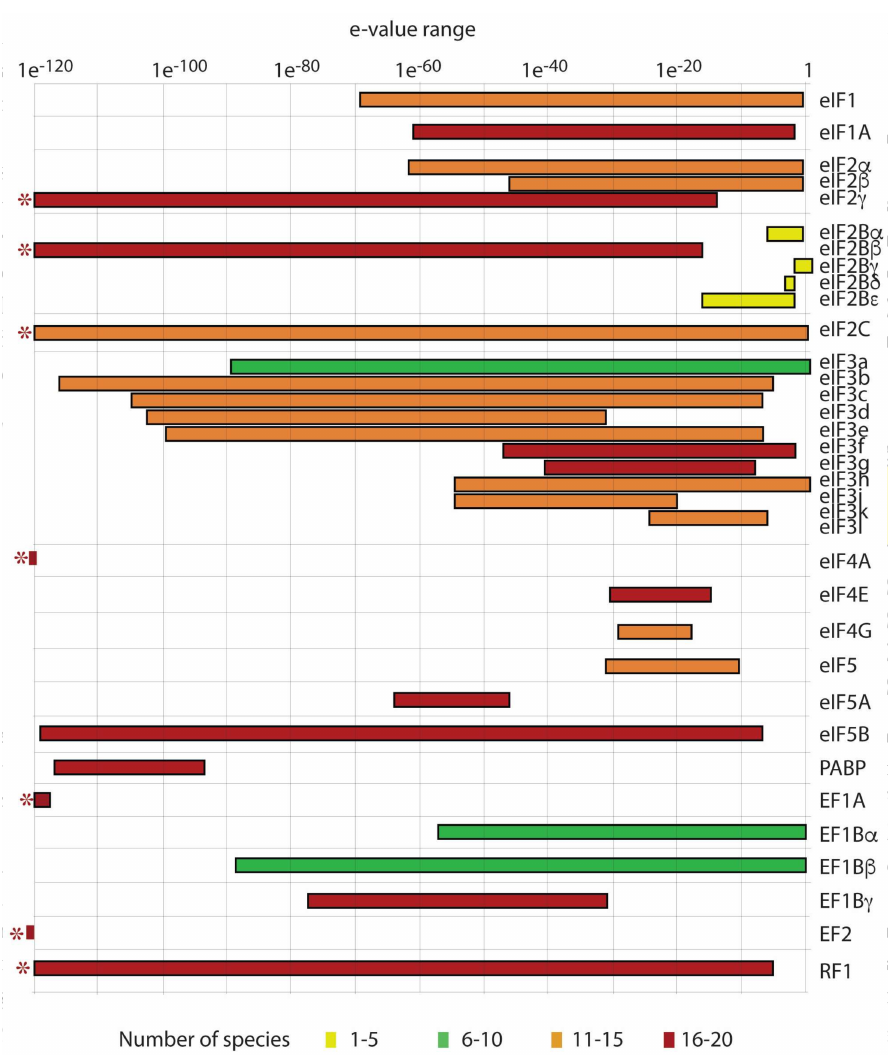
Figure 2. A list of eukaryotic initiation factors from Arabidopsis thaliana was used to query the dinoflagellate TSA using tBLASTn. Query sequences are listed at right, and the range of e-values (from e − 120 to 1) are shown as horizontal red bars; an asterisk at left indicates an e-value of 0. The number of species in which hits were recovered is indicated by the color in the bar. Most of the eIF2B subunits are not found in dinoflagellates. Factors eIF4E. eIF4G and eIF5 are